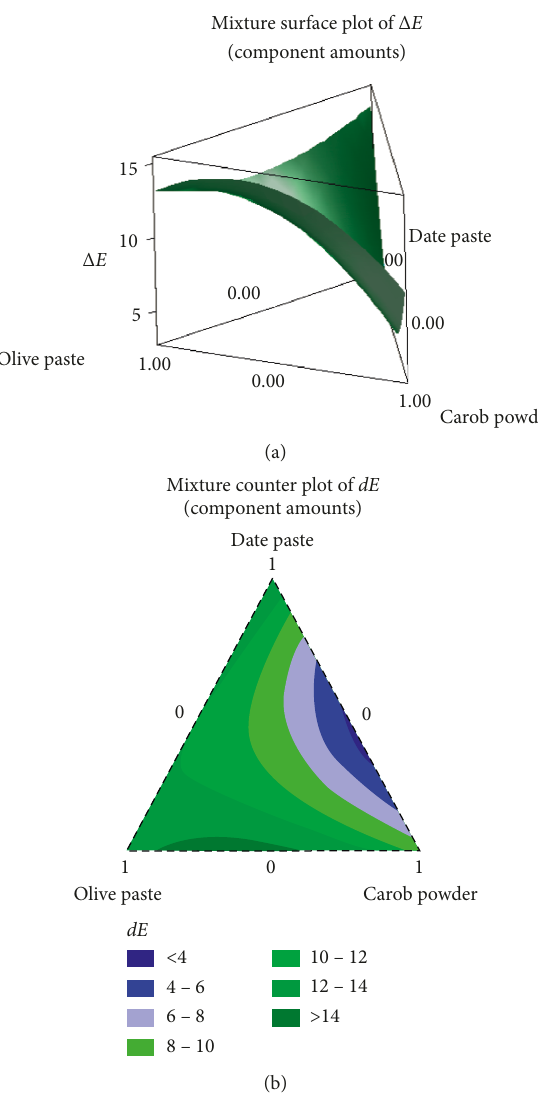
Figure 4: Response surface (a) and contour curve (b) related to the variation of candy total color difference hardness ( Δ E ∗ ) on function of proportions of basic